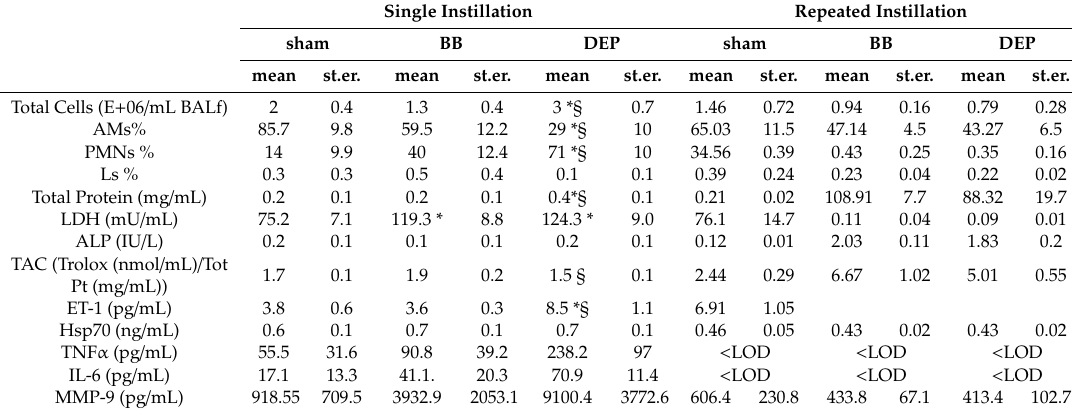
Table 1. Cell count and biochemical BALf analysis. Table summarizes results of cell count and biochemical analysis in BALf of sham, BB- and DEP-treated mice after 3 h from the single intratracheal instillation (day 0) and after 24 h from the last intratracheal instillation (day 6). All the data are expressed as mean ± standard error. Concentrations under the detection limit are reported as < LOD. Statistical di ff erences were tested by One-way ANOVA followed by Bonferroni post-hoc comparison; * p < 0.05 vs. sham, § p < 0.05 vs. BB. Single Instillation Repeated Instillation